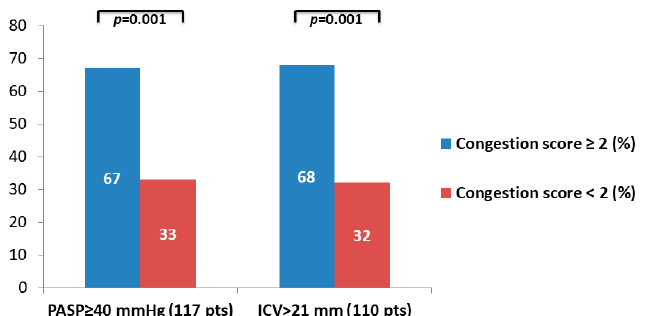
Figure 1. Congestion score ≥ 2 prevalence in patients with PASP ≥ 40 mmhg and in patients with ICV > 21 mm.